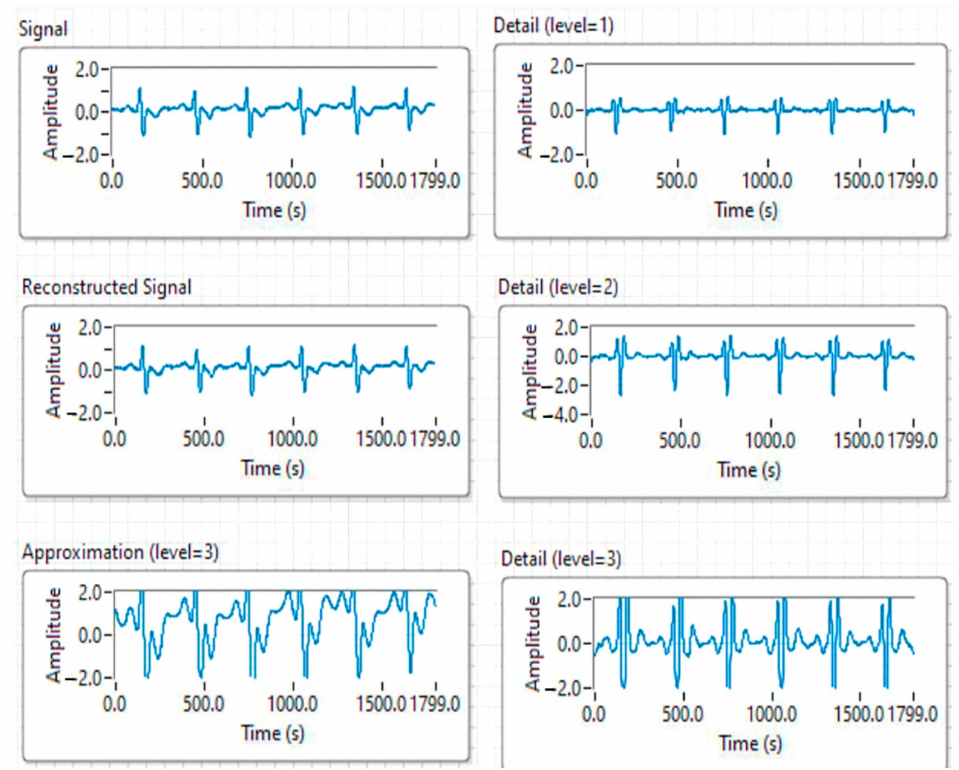
Figure 14. ECG signal analysis results using wavelet transform and Haar